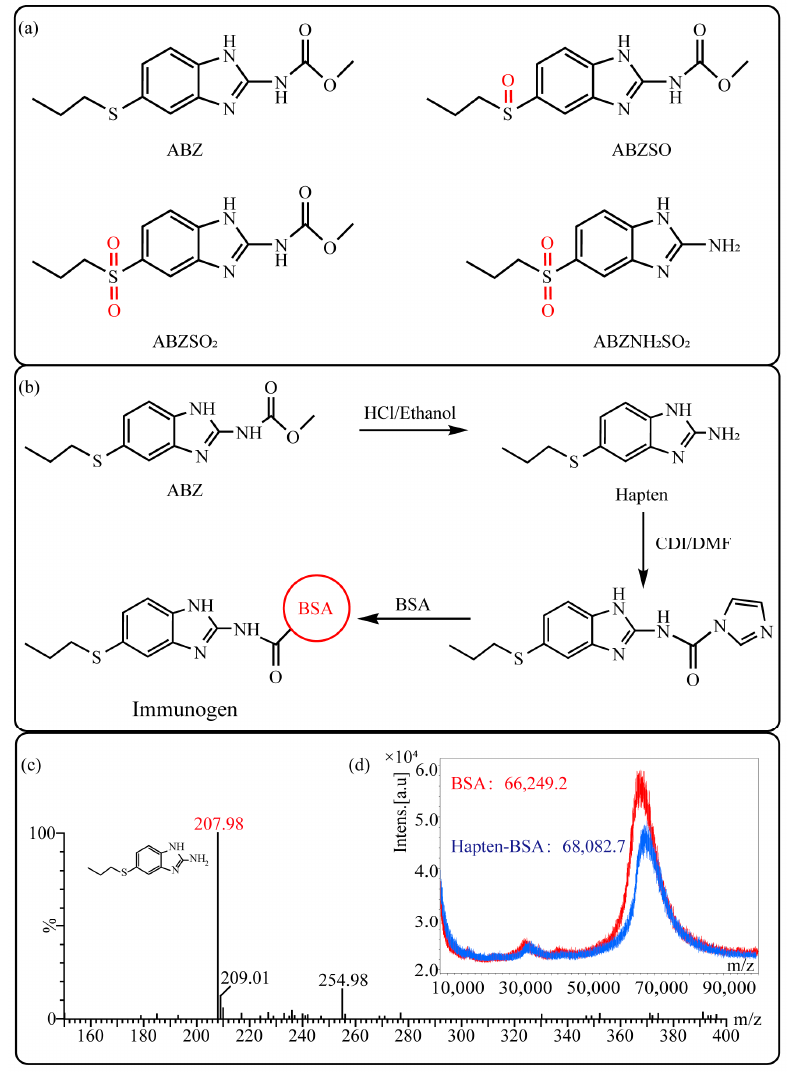
Figure 1. Chemical structures and synthesis route used in the study: ( a ) Chemical structure of four ABZs. ( b ) Synthesis route of hapten and immunogen. ( c ) Mass spectrometry characterization of hapten and ( d ) Matrix-assisted laser desorption/ionization time-of-flight mass spectrometry characterization of hapten- bovine serum albumin (BSA) conjugates.